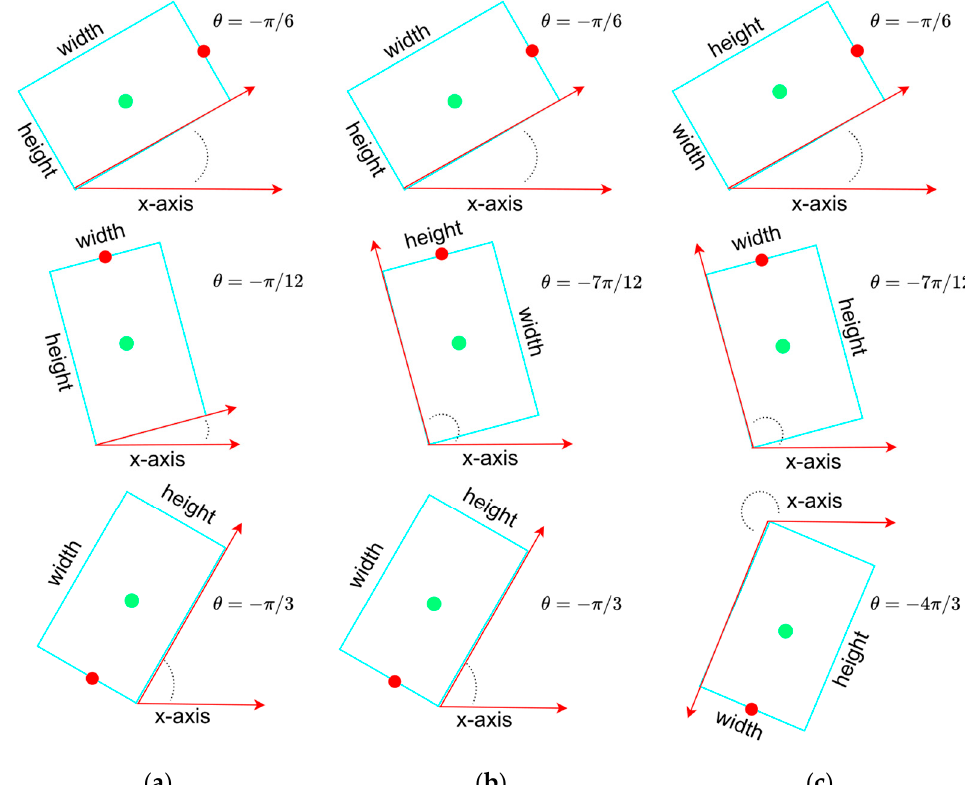
Figure 1. Three different definitions of the angle, width and heigh of the OBB. Green point and red point represent center point and front point of the OBB, respectively. ( a ) The definition of an OBB in OpenCV. 𝜃 ranges from −π /2 to 0. ( b ) The extended version of the OBB definition in OpenCV. In this case, the width of OBB is always set to the longer side. 𝜃 range from −π to 0. ( c ) The OBB definition in our proposed work. A front point is added to guide the angle prediction. 𝜃 ranges from − 2 π to 0.